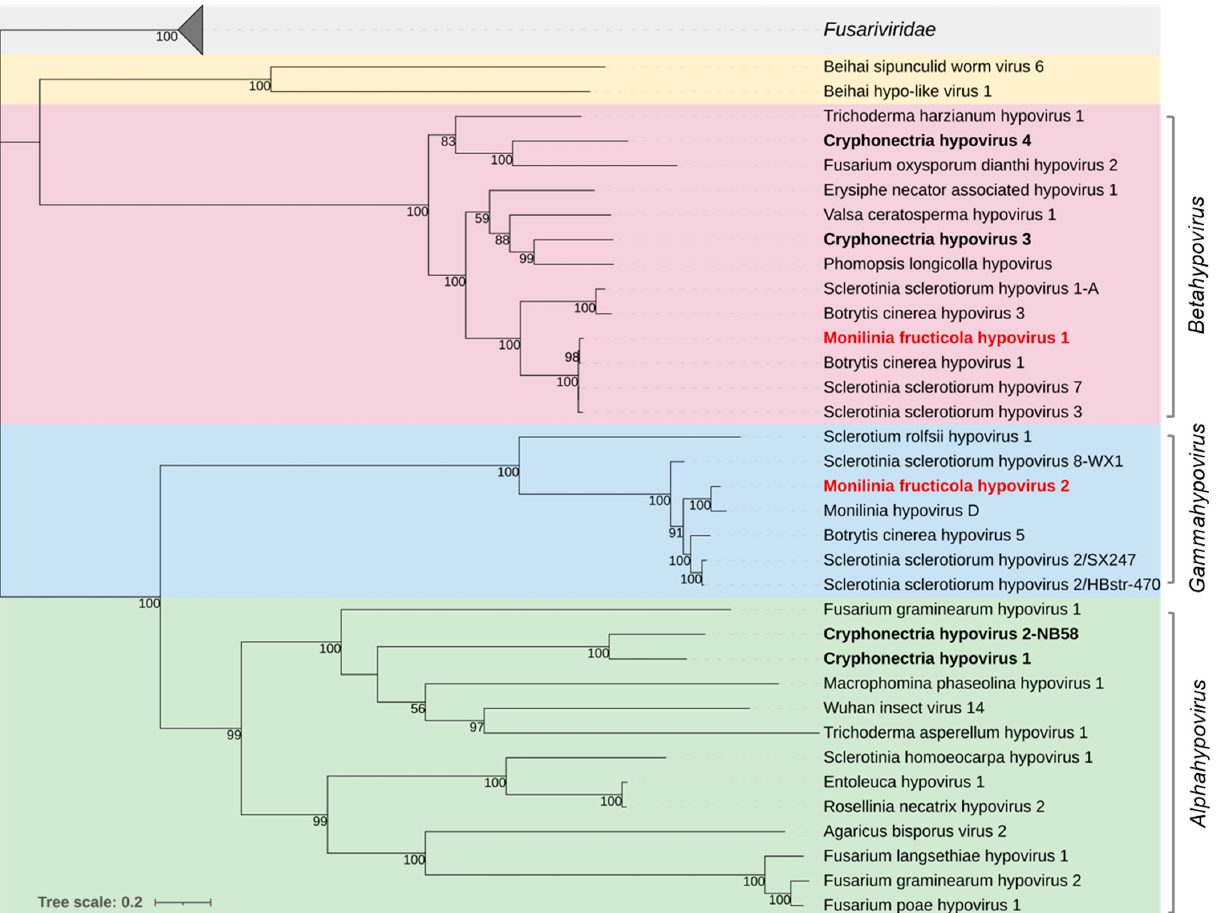
Figure 3. Maximum likelihood phylogenetic tree based on multiple amino acid sequence alignment of the RdRp proteins of viruses in the family Hypoviridae and its relationship with the closely related proposed family Fusariviridae . The three genera in the Hypoviridae family are represented with different coloured boxes: Alphahypovirus (green), Betahypovirus (red), and the proposed genus Gammahypovirus (cyan). The Beihai hypo-like virus and Beihei sipunculid worm virus 6 (yellow) are proposed as members of an additional genus [65]. The type species are in bold black. Mycoviruses found in this work are in bold red. The numbers on nodes, shown for values greater than 50%, are the results of 1000 bootstrap analyses. The scale bar represents a genetic distance of 0.2 amino acid substitutions per site. The list of accession numbers of the analysed sequences is in Table S1.